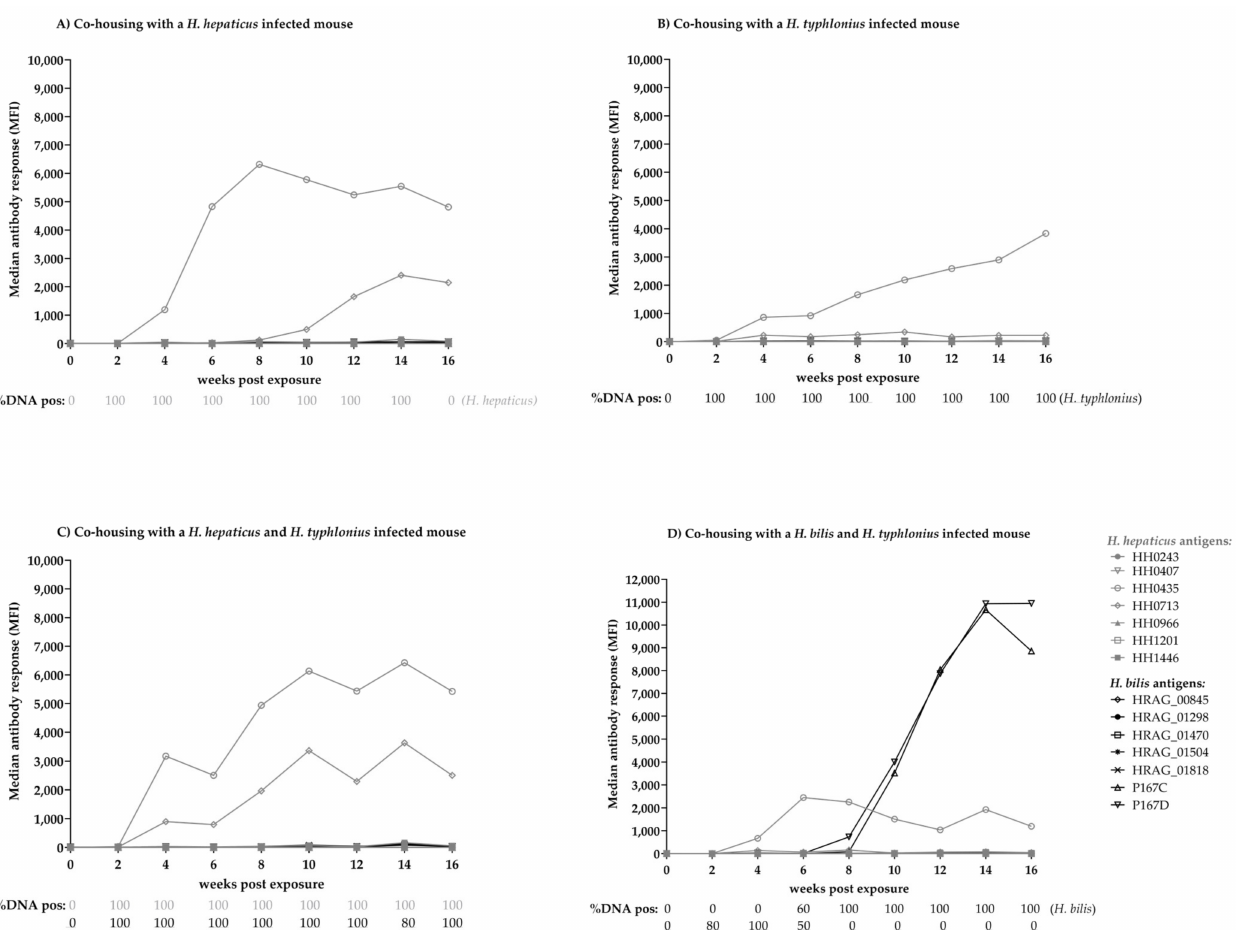
Figure 3. Median antibody response [MFI] to H. hepaticus and H. bilis antigens and % DNA-positivity in feces after co-housing of each group of five mice with ( A ) a H. hepaticus -infected mouse, ( B ) a H. typhlonius -infected mouse, ( C ) a H. hepaticus / H. typhlonius dual-infected mouse and ( D ) a H. bilis / H. typhlonius dual-infected mouse over a course of 16 weeks follow-up. Each group of five mice was